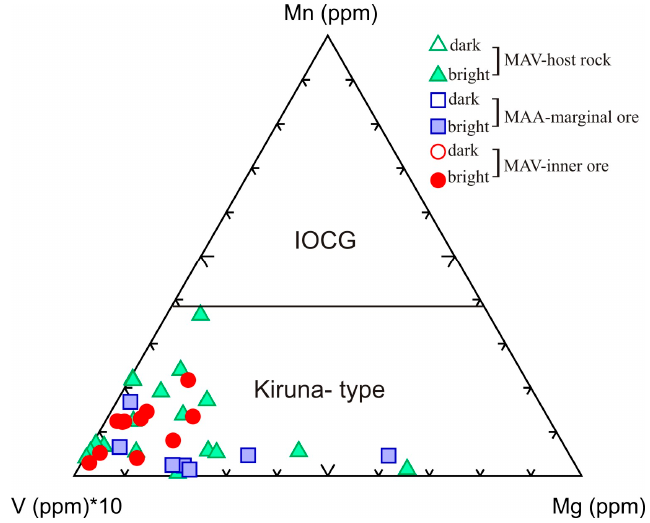
Figure 12. Mg-V-Mn ternary plot, showing boundary between apatites from IOCG and Kiruna-type IOA deposits [55]. Chadormalu apatites plot in the Kiruna-type field.